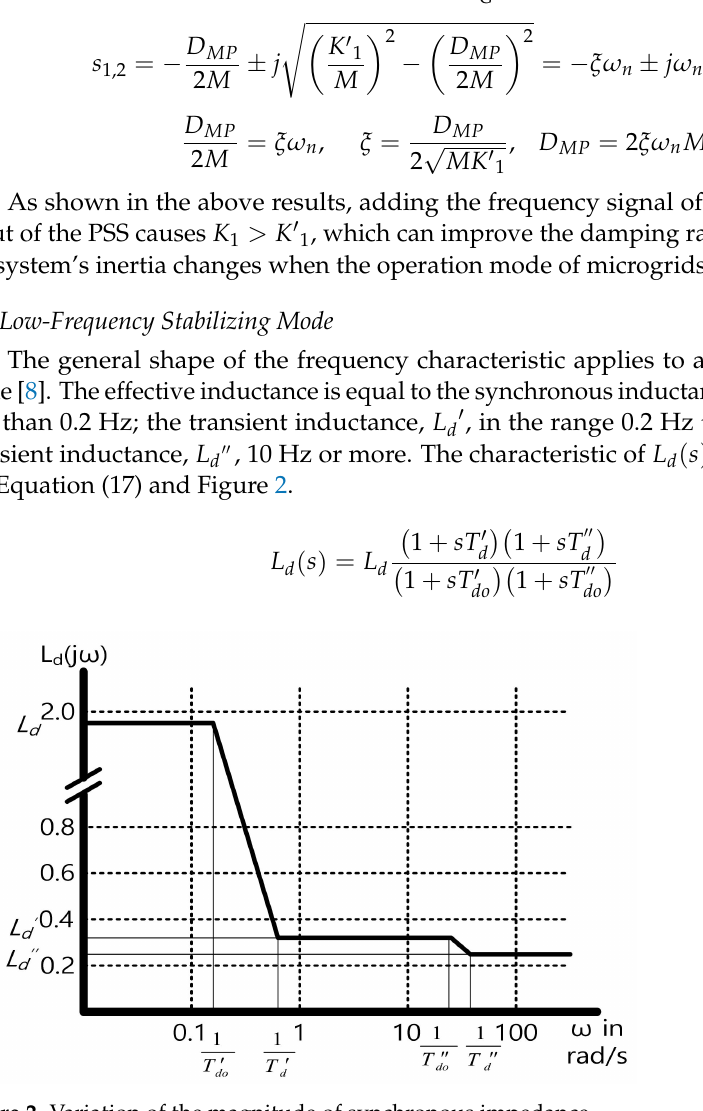
Figure 2. Variation of the magnitude of synchronous